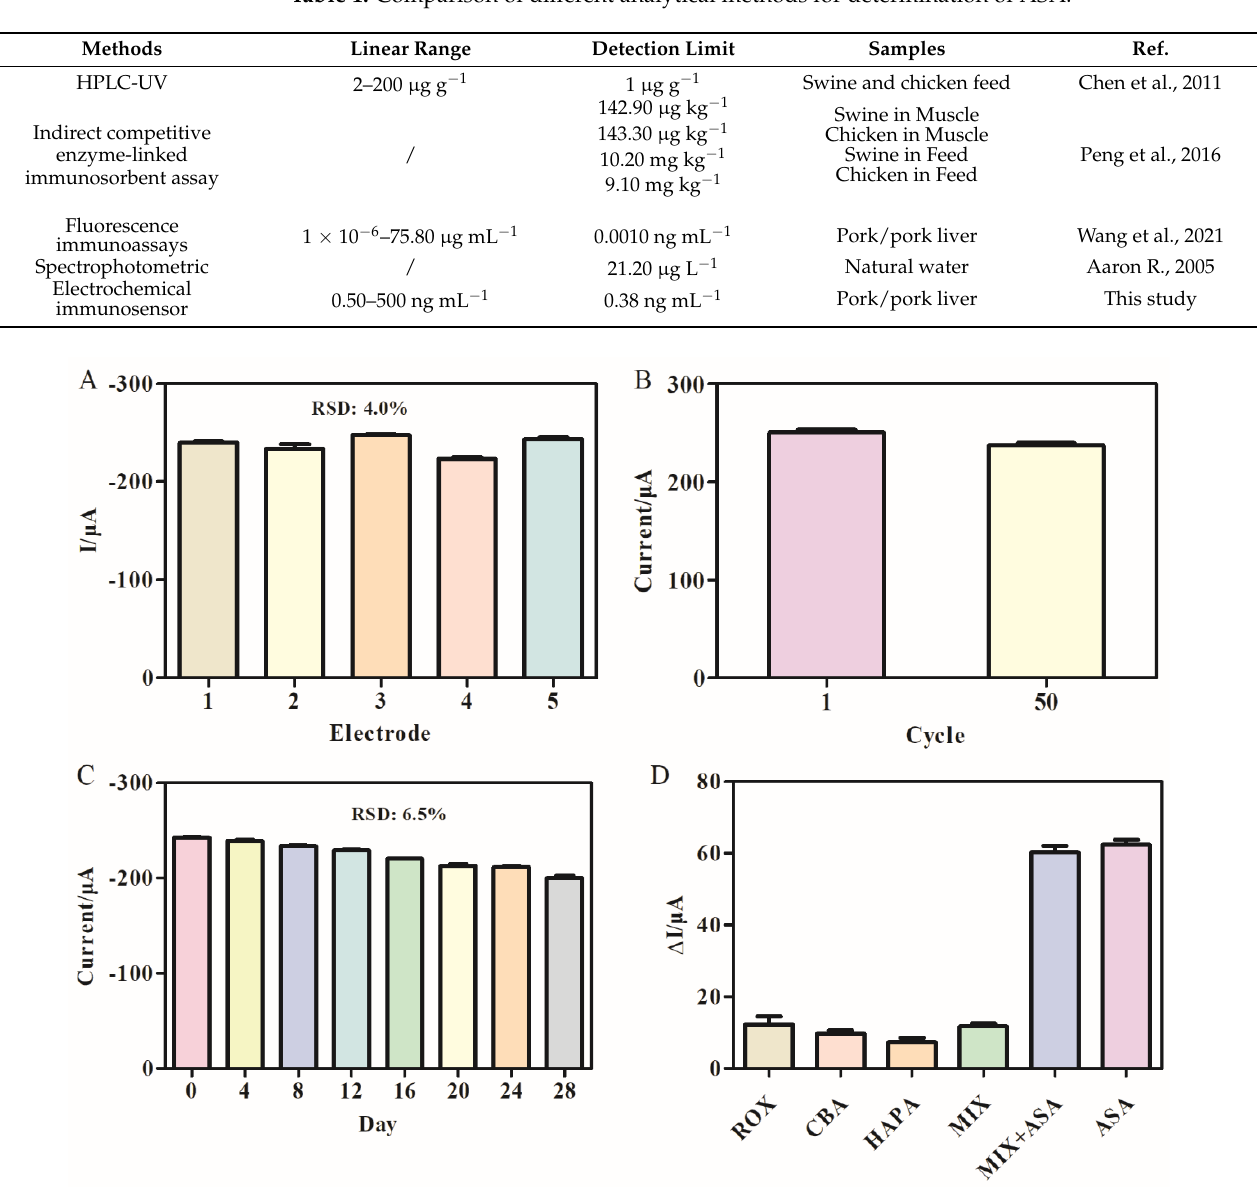
Figure 7. ( A ) Reproducibility of five independent immunosensors for ASA. ( B ) Stability of the proposed immunosensor at consecutive cycle scans 50 times. ( C ) The stability of the electrochemical immunosensors at various storage periods. ( D ) Selectivity of the ASA immunosensor: 100 ng mL −1